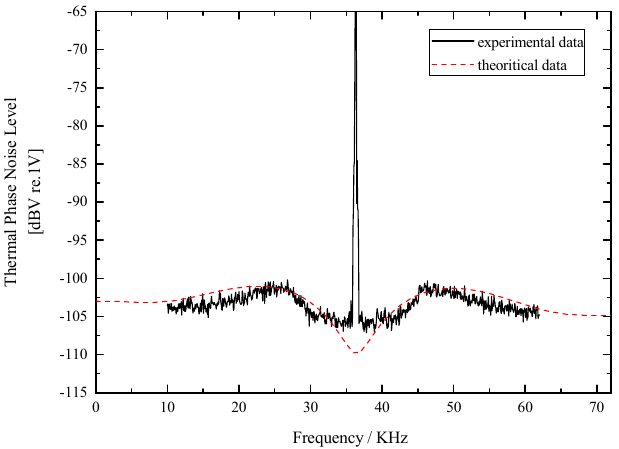
Figure 5. Experimental thermal phase noise voltages obtained with the spectrum analyzer with 1.37 rad square-wave modulation and the corresponding calculated result.